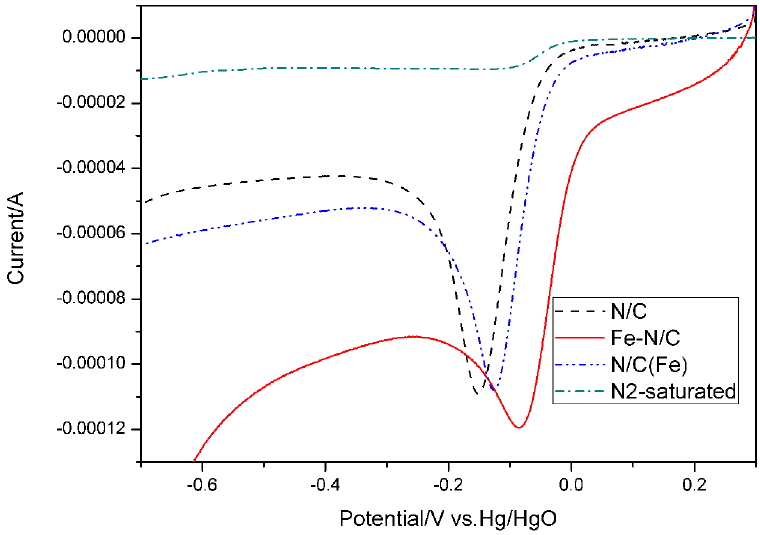
Figure 1. Linear sweep voltammograms of N/C, Fe–N/C and N/C (Fe) at a scan rate of 50 mV·s − 1 in O 2 - and N 2 -saturated 0.1 M KOH solutions.